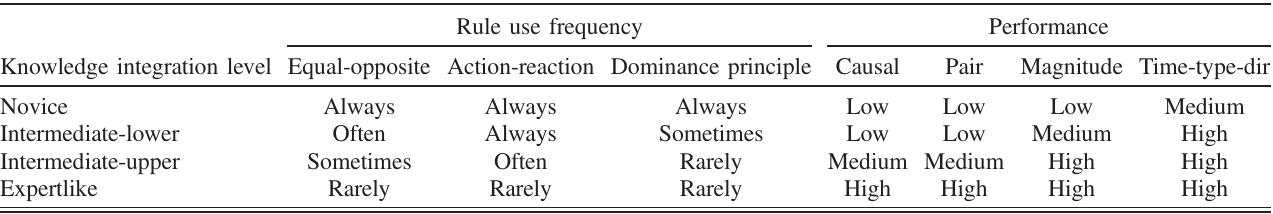
TABLE III. Summary of students ’ use of rules and performance on N3L properties separated by the four levels of knowledge integration. For rule use frequency, students at each level are categorized as using the rule always, often, sometimes, or rarely. Performance on N3L properties is then categorized as low, medium, or high. Rules summarized here include use of the equal-and- opposite rule, directly relating action-reaction to cause, and reliance on a dominant feature to determine